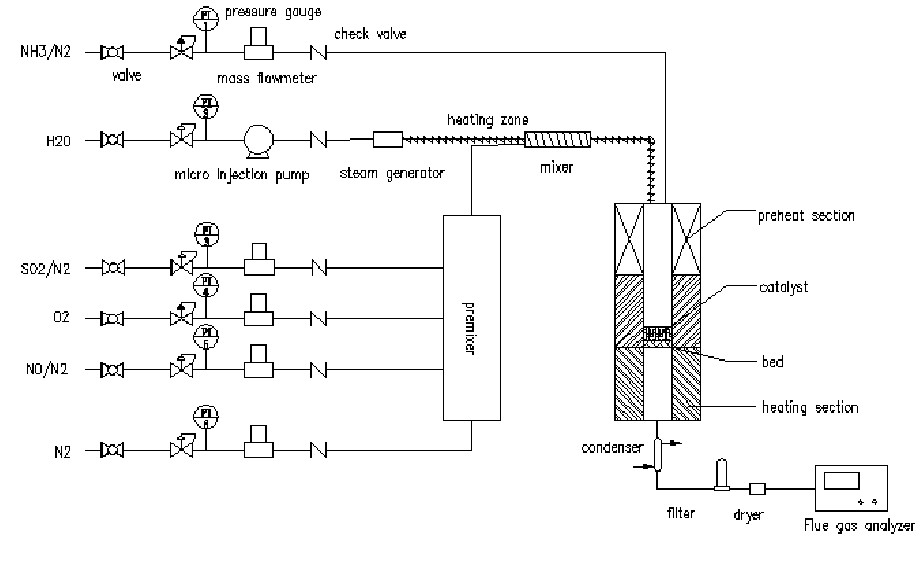
Figure 8. Schematics for the fixed-bed tubular flow